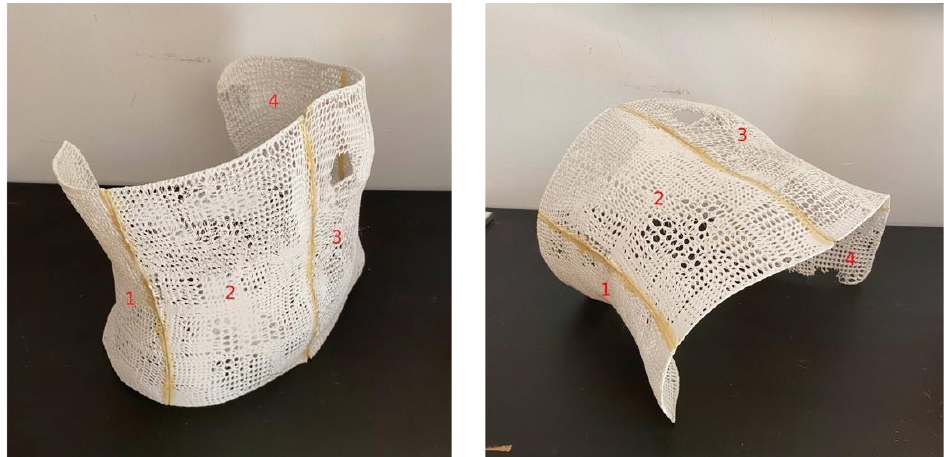
Figure 5. Manufactured mask using 3D printing with the 4 parts marked as 1, 2, 3 and 4..